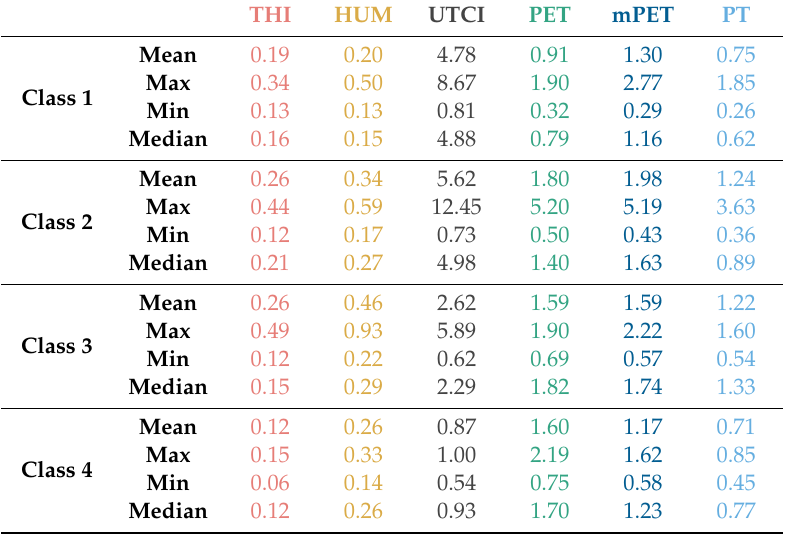
Table12. Descriptivestatisticsoftheindices’sensitivitytoWSchangeratesunderdi ff erentT a